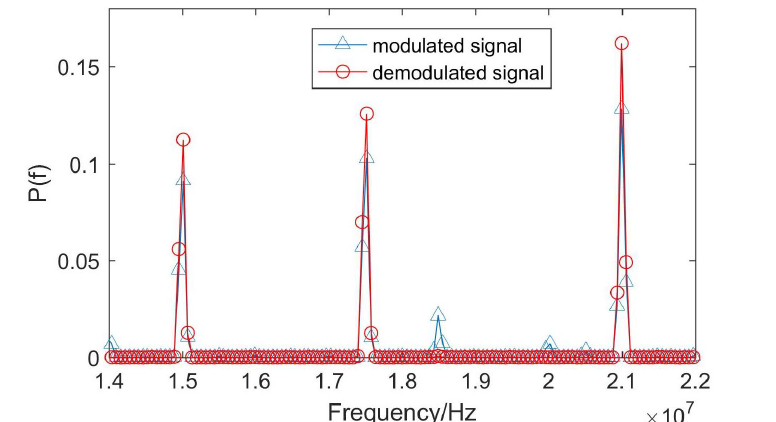
Figure 8. Spectra of the modulated and demodulated